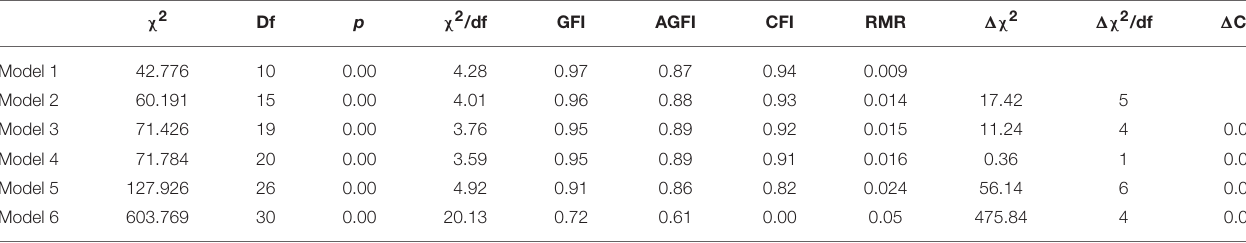
TABLE 6 | Comparative indexes for fourth model (dimension parental permissiveness). χ 2 Df p χ 2 /df